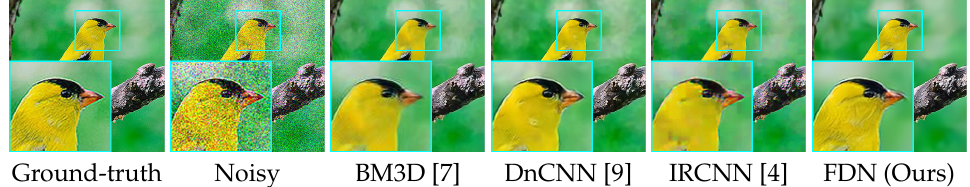
Figure 1. Visual comparison on CUB-200 [16] with σ = 50 AWGN. Our method restores finer feathers, clearer eyes, and a sharper beak. Zooming in on a high-resolution display will allow better observation of the